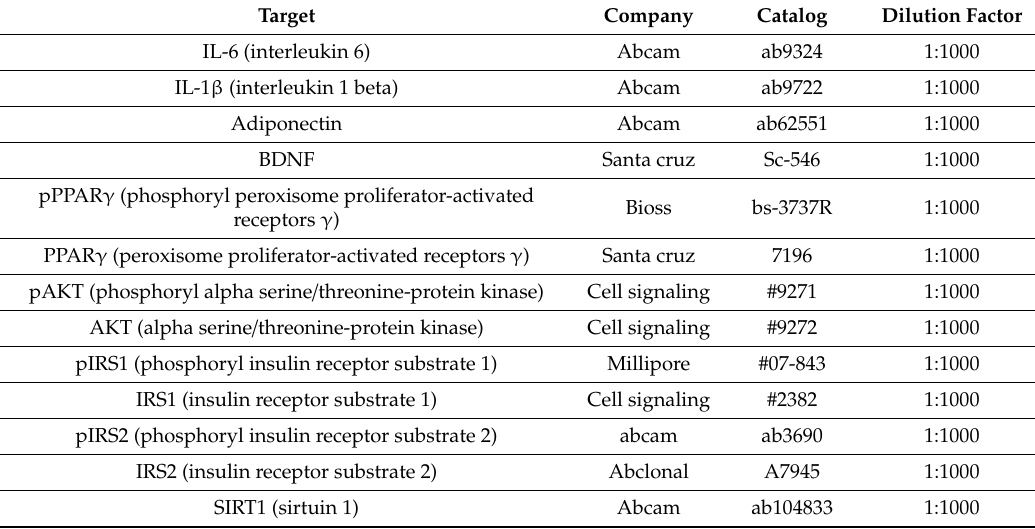
Table 2. Primary and secondary antibodies used for Western